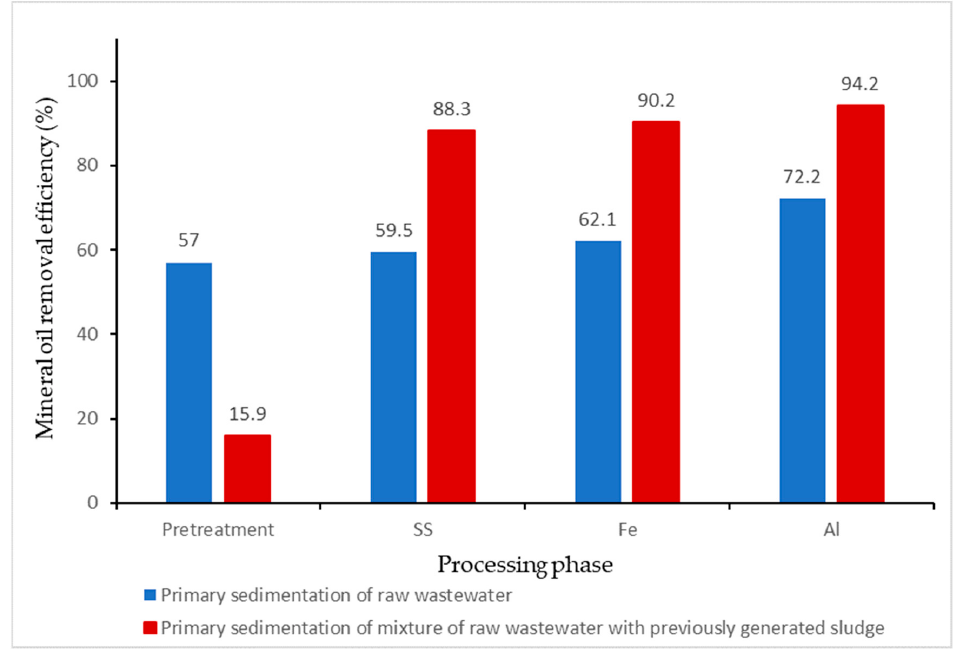
Figure 2. Comparison of removal efficiency of mineral oil by primary sedimentation of raw wastewater followed by EF/EC process, during individual treatment stages using stainless steel (SS), iron (Fe) and aluminum (Al) electrodes, and primary sedimentation of a mixture of raw wastewater with previously generated sludge followed by EF/EC process, during individual treatment stages using stainless steel (SS), iron (Fe), and aluminum (Al) electrodes.